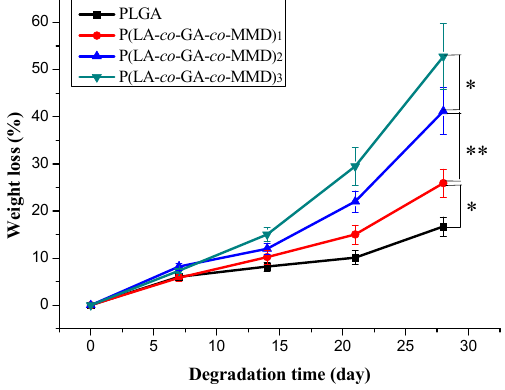
Figure 4. In vitro degradation of PLGA and P(LA- co -GA- co -MMD) nanofibrous scaffolds in PBS solution (pH = 7.4) at 37 °C for 28 days. (mean ± SD, n = 3, * p ≤ 0.05, ** p ≤ 0.01).